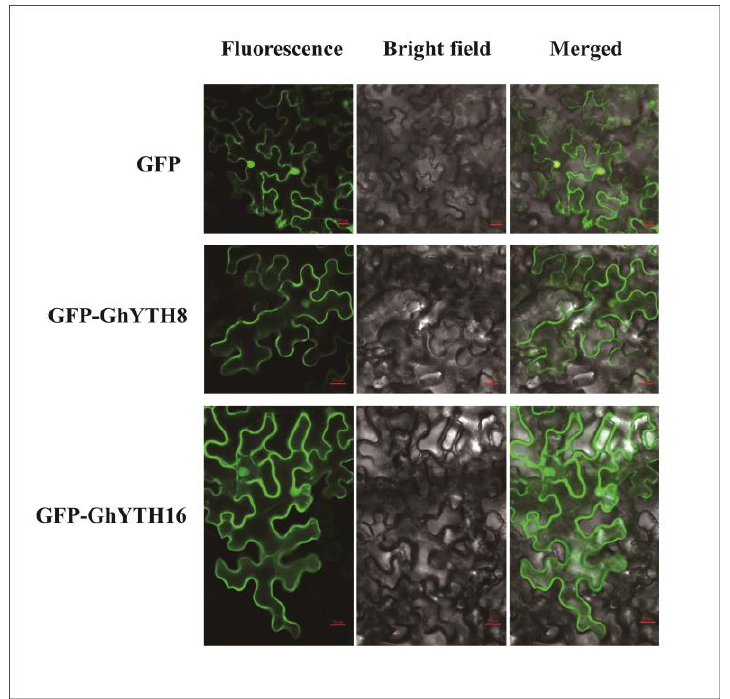
Figure 10. Subcellular analysis of GhYTH8 and GhYTH16 proteins. The GhYTH8::GFP, GhYTH16::GFP, and GFP alone were transiently expressed via agroinfiltration using N. benthamiana leaves. Green fluorescence was observed with confocal laser microscopy (left). The same cells were also observed by transmission microscopy, and both images were merged (from the middle to the right).